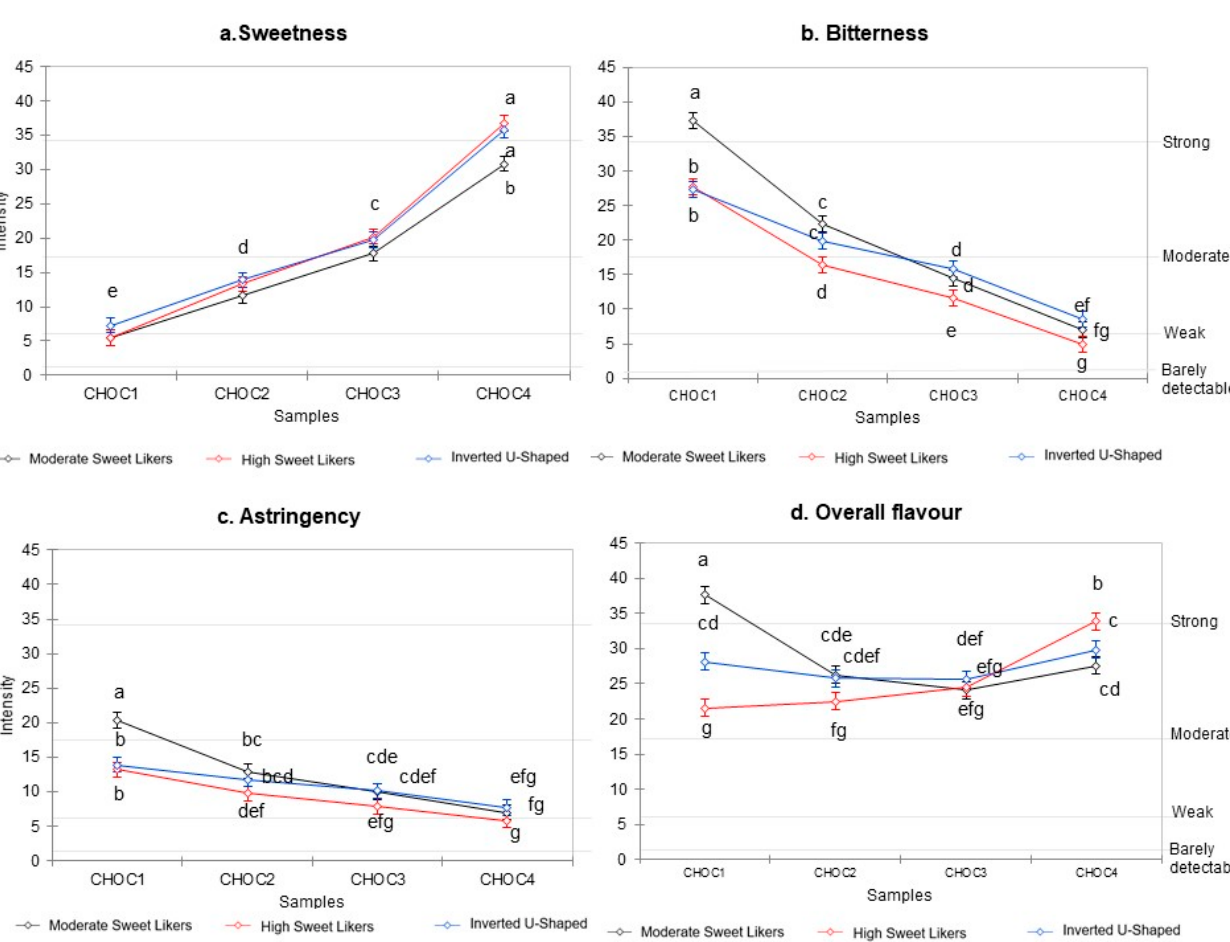
Figure 3. Mean intensity ratings of sweetness ( a ), bitterness ( b ), astringency ( c ) and overall flavour ( d ) for each of the three clusters as a function of sucrose concentration under the four test conditions (CHOC1: sucrose concentration 38 g/kg, CHOC2: 83 g/kg, CHOC3: 119 g/kg, CHOC4: 223 g/kg). a,b,c,d,e,f,g Different letters indicate a significant difference in the Bonferroni post hoc test (0.05). When the letter is the same for all clusters for the same sample only one letter is re- ported.